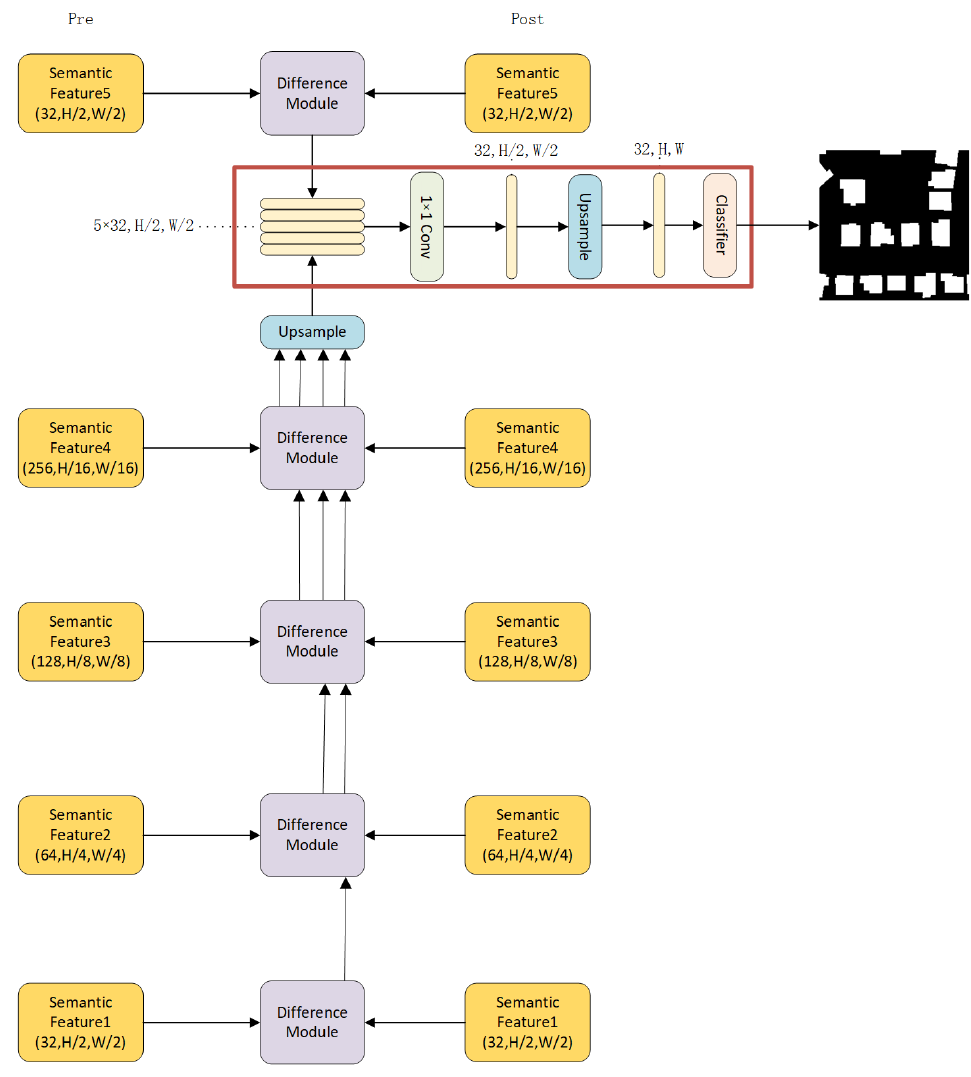
Figure 6. The details of the change decoder. The red box is the semantic multiscale feature fusion modules.